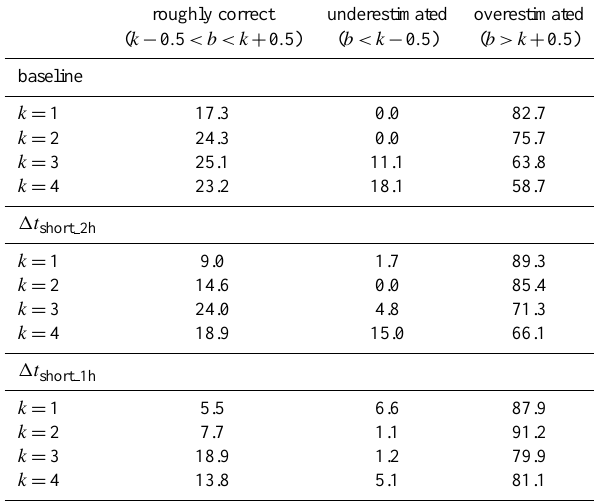
Table 3. Accuracy of best fit exponent b calculations when cor- relating N 3 − 6 ∼ [H 2 SO 4 ] b . The accuracy is given as percent- age (%) of analysed events in each of the following three classes: events for which the analysis predicts roughly the correct nucle- ation mechanism ( k − 0 . 5 ≤ b ≤ k + 0 . 5, where k is the nucleation exponent in the simulation and b is the best fit exponent from the analysis); events for which the exponent is clearly underestimated ( b <k − 0 . 5); and events for which the exponent is clearly overesti- mated ( b >k + 0 . 5).